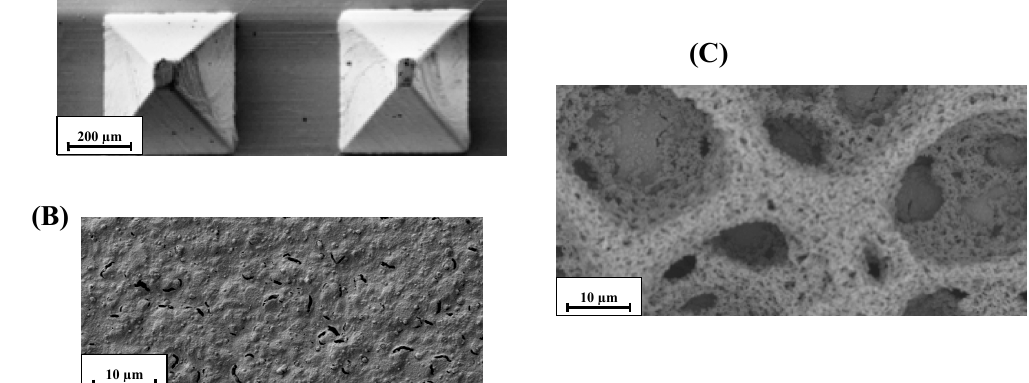
Figure 2. SEM images of ( A and B ) a bare microneedles gold electrode and ( C ) an h-PG microneedles gold electrode with different magnifications. ( A ) 6.00 kV, mag. x100; ( B and C ) 10.0 kV, mag. x1000.